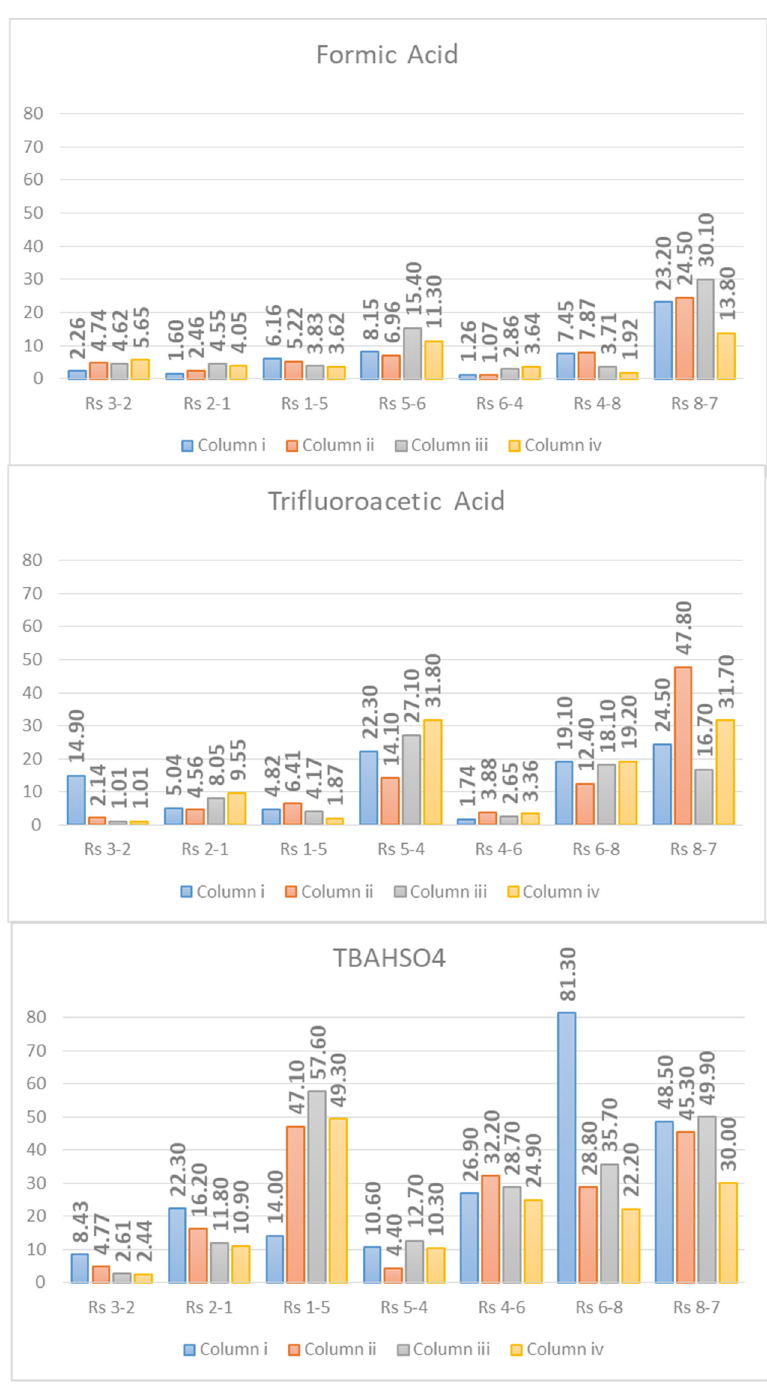
Figure 7. Resolution ( Rs )